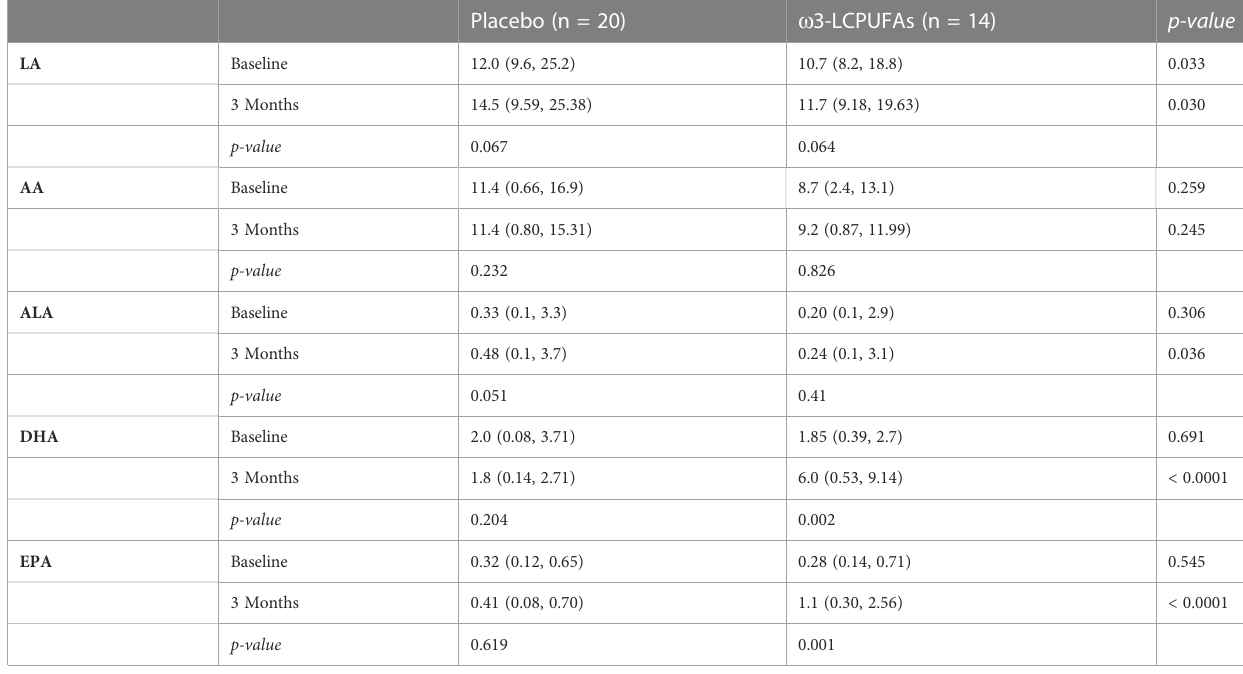
TABLE 4 Fatty acid composition of erythrocyte membranes in children with acute lymphoblastic leukemia from baseline and three months of treatment with w 3-LCPUFAs. Placebo (n =